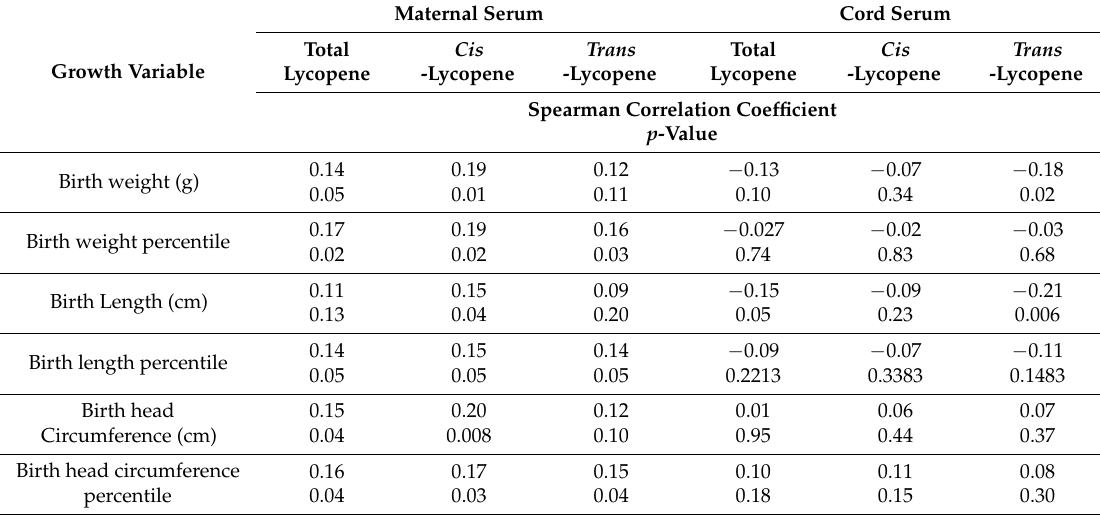
Table 2. Univariate correlations between maternal and cord serum total, cis -, and trans -lycopene and infant growth variables.